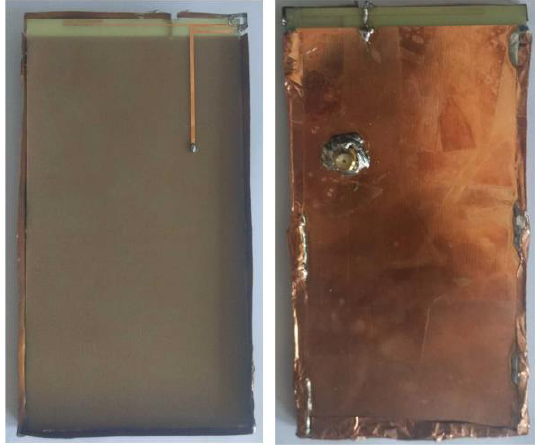
Figure 7. Photos of the fabricated antenna.